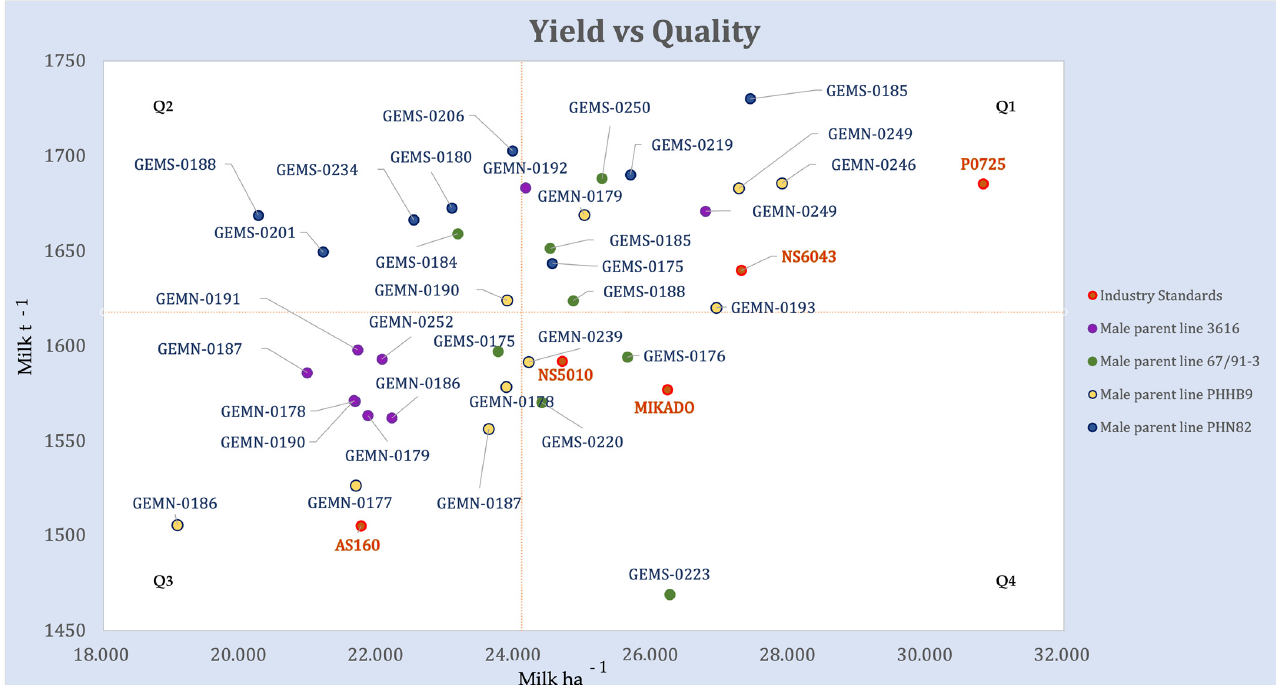
Figure 3. Genotype BLUP values plotted on a Milk ha − 1 vs. Milk t − 1 plane, which groups genotypes into four distinct quadrants. The dot color represents the male parent of the hybrid. Horizontal and vertical lines represent the grand means for Milk ha − 1 and Milk t − 1 . Commercial check hybrids in the experiment are labeled by green dots.